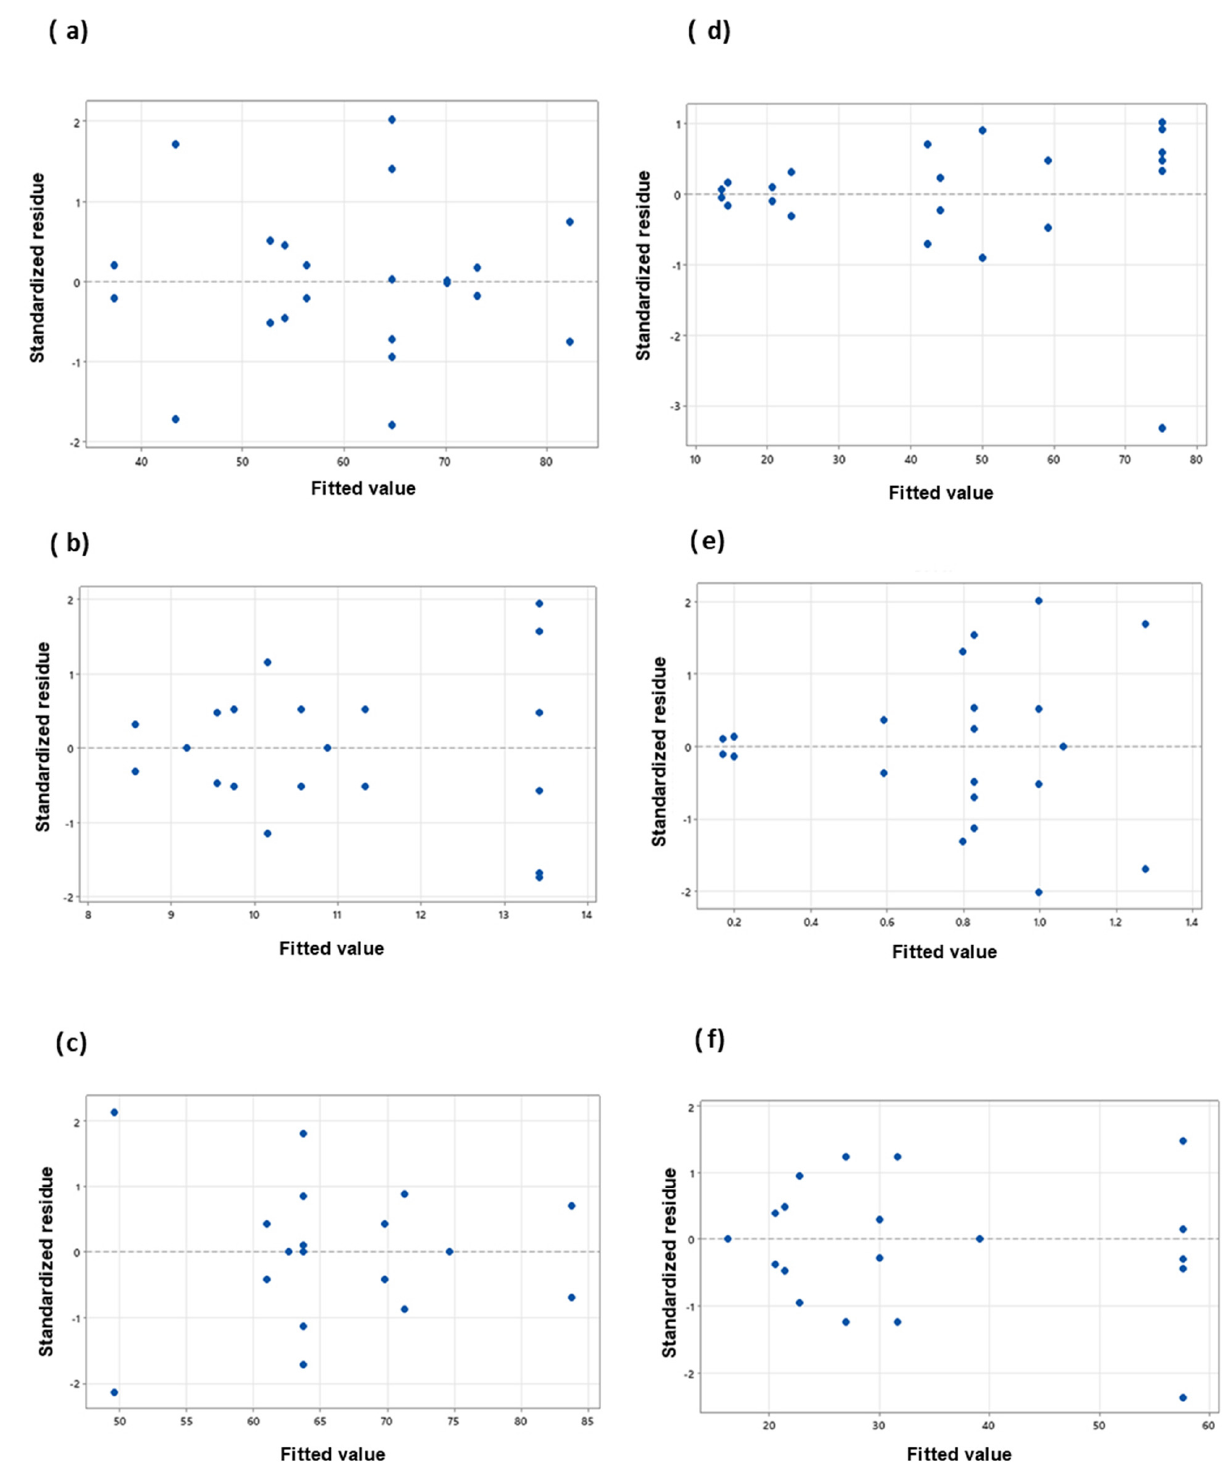
Figure 5. Standardized residues vs. fitted values plot for; ABTS (left) and DPPH (right) antioxidant capacities, ( a , d ) peel; ( b , e ) endocarp and ( c , f ) kernel.